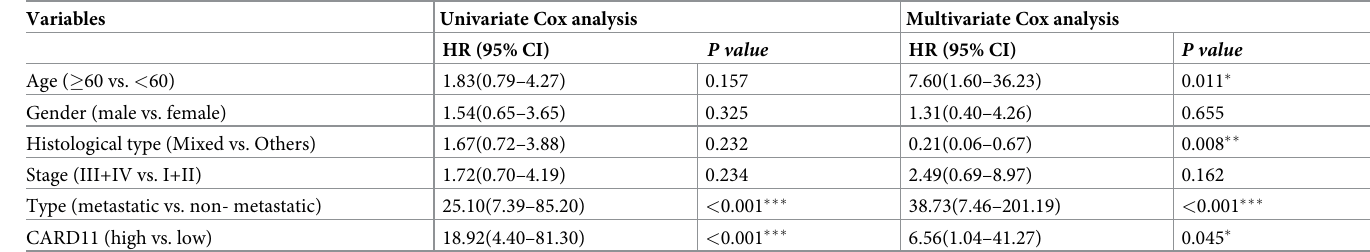
Table 2. Univariate and multivariate Cox regression analyses for overall survival of uveal melanoma patients based on CARD11 expression.